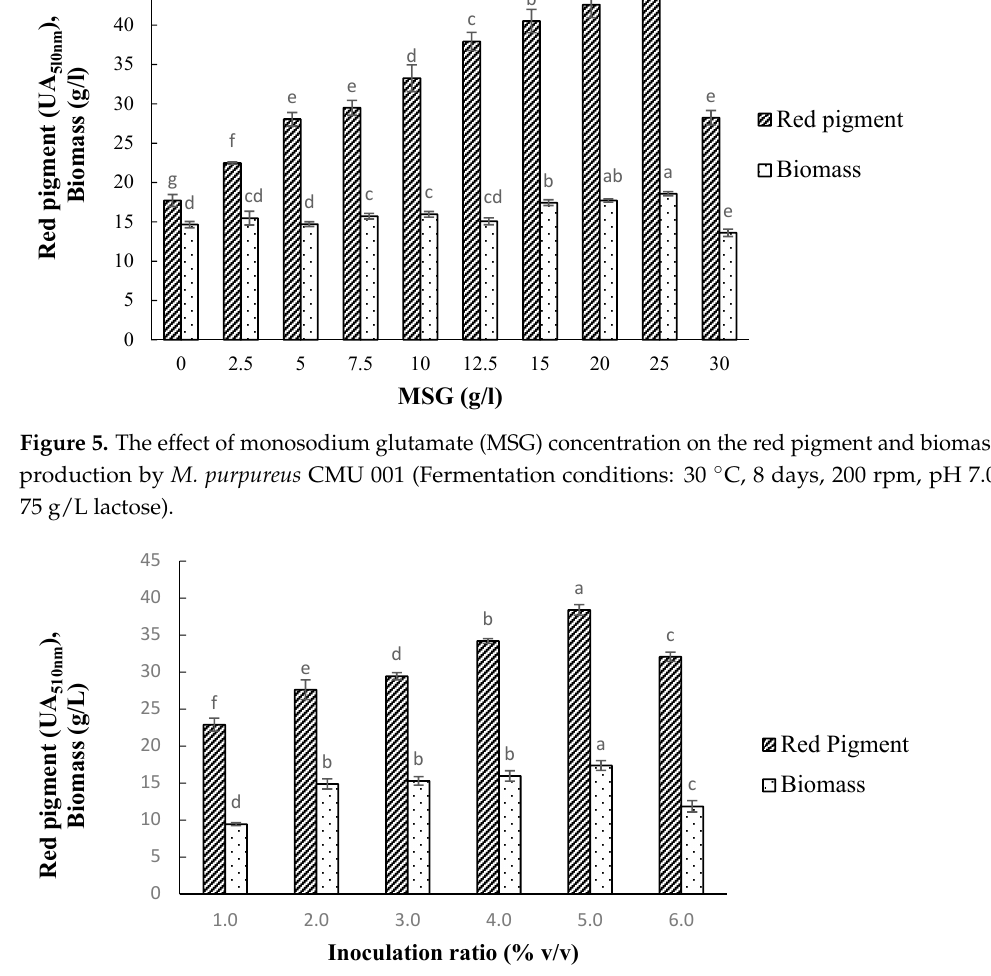
Figure 6. The effect of inoculation ratio on the red pigment and biomass production by M. purpureus CMU 001 (Fermentation conditions: 30 °C, 8 days, 200 rpm, pH 7.0, 5 g/L MSG, 75 g/L lactose.